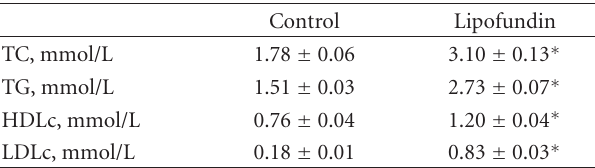
Table 1: E ff ects of Lipofundin on serum lipid profile. Values rep- resent the mean ± standard deviation. Asterisks represent statistical di ff erences ( P < 0 .